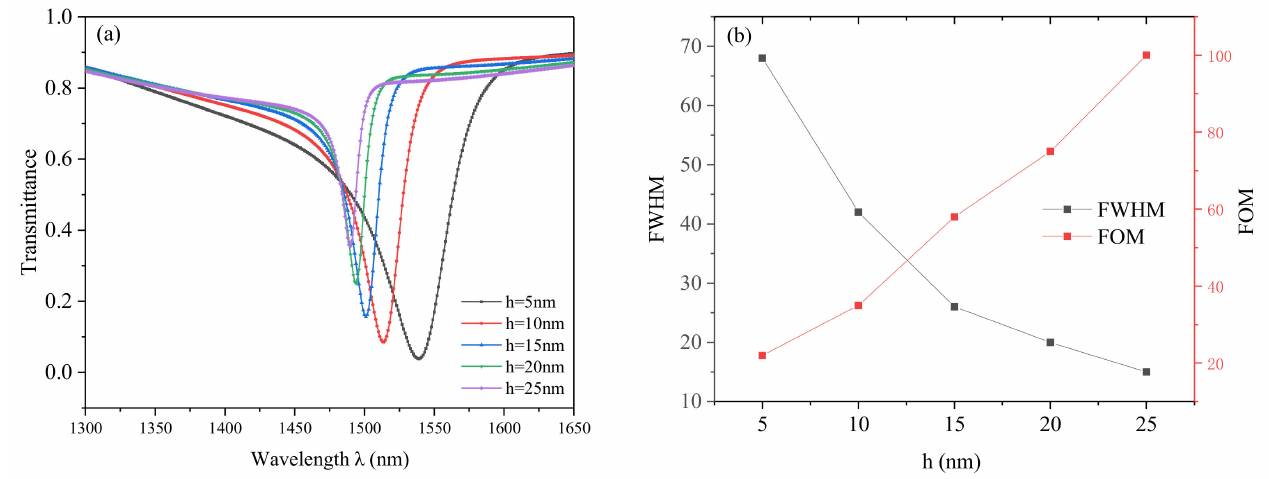
Figure 8. ( a ) Transmission spectra of h varying from 5 to 25 nm; ( b ) the tendency of full width at half maximum (FWHM) and figure of merit (FOM) with increasing h .